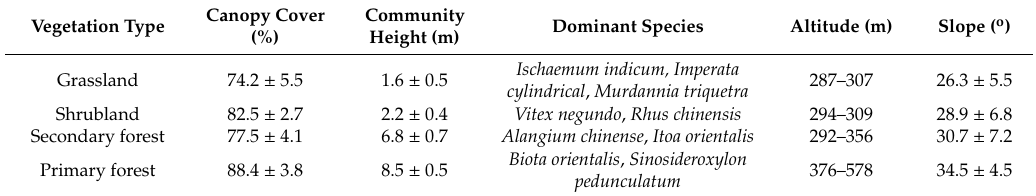
Table 1. The plot characteristics of the four successional stages in a karst region of Southwest